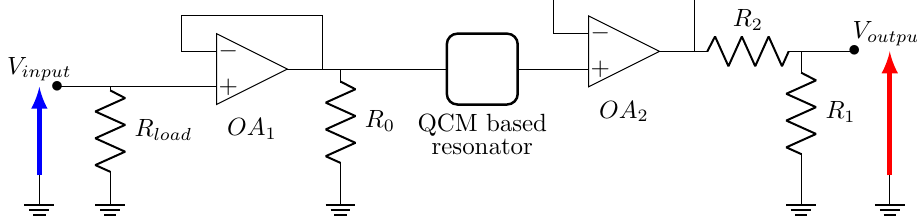
Figure 7. Detailed circuit of the entire analog filter standing for resonator 2 in Figure 1. The QCM based resonator corresponds to Figure 4.